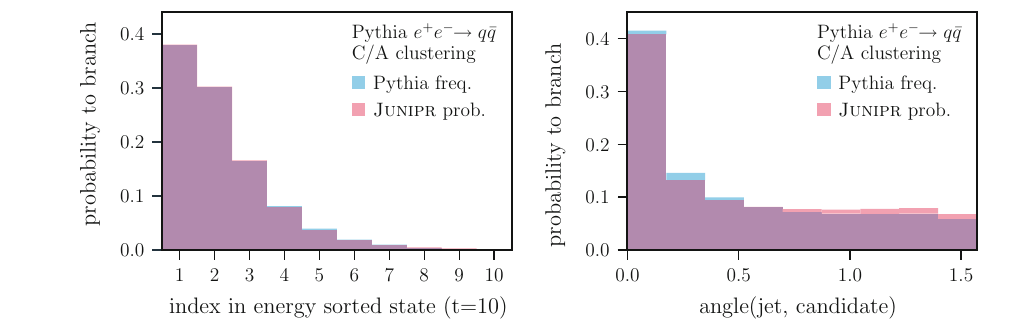
a function of intermediate state length. (Right) P end as a function of the maximum angle between the jet axis and momenta in the intermediate state